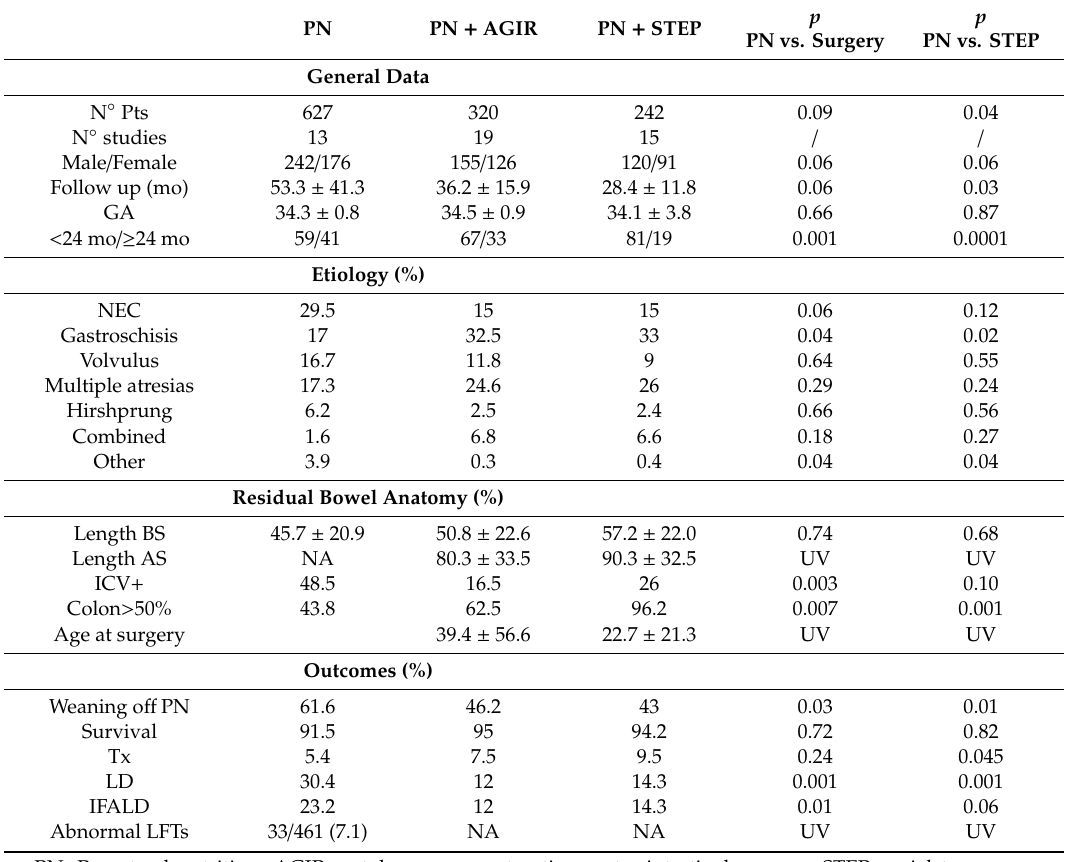
Table 4. Summary of the results according to treatments.